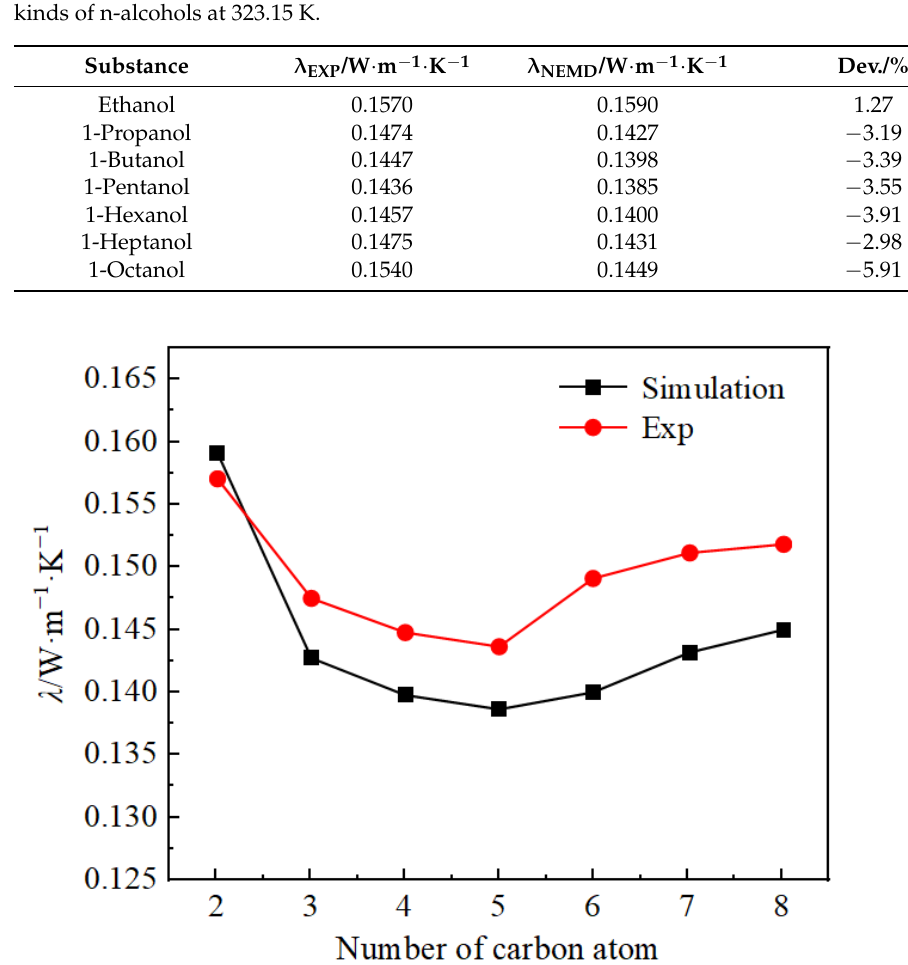
Table 6. Comparison between experimental and simulated values of thermal conductivity for seven kinds of n-alcohols at 323.15 K.